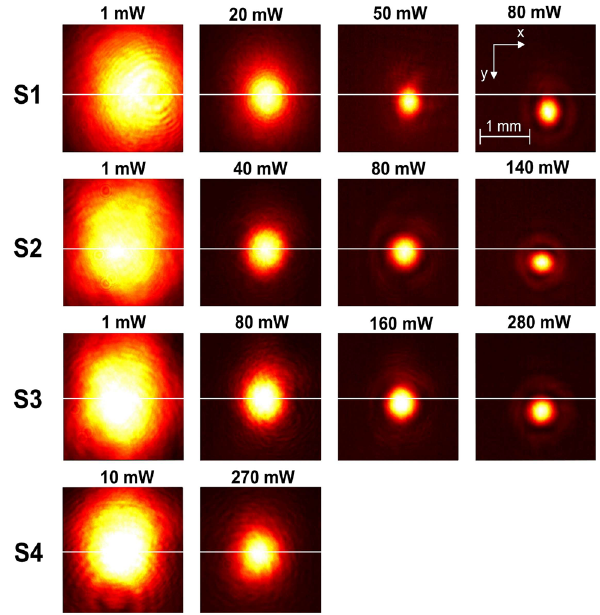
Figure 4: Far-field beam width profiles under fs excitation of samplesS1, S2, S3andS4 forvariousopticalinput powersrecorded at position 1 and d = 15 mm. The fi gure demonstrates similar behavior for all samples: the fi rst column shows the initial pro fi le, the second column shows the required power for shrinking of the beamwidth to approximately half of the initial, the third column shows the appearance of Airy-type diffraction interference, and the fourth column shows further shrinkage of the central Airy disk and downward displacement δ y of the beam pro fi le due to convection currents. The horizontal line shows the initial position of the beam center on the Y direction. The inset scale and axes apply for all fi gures. The x axis is horizontal, and the y axis is vertical and pointing downwards to de fi ne the positive direction of δ y